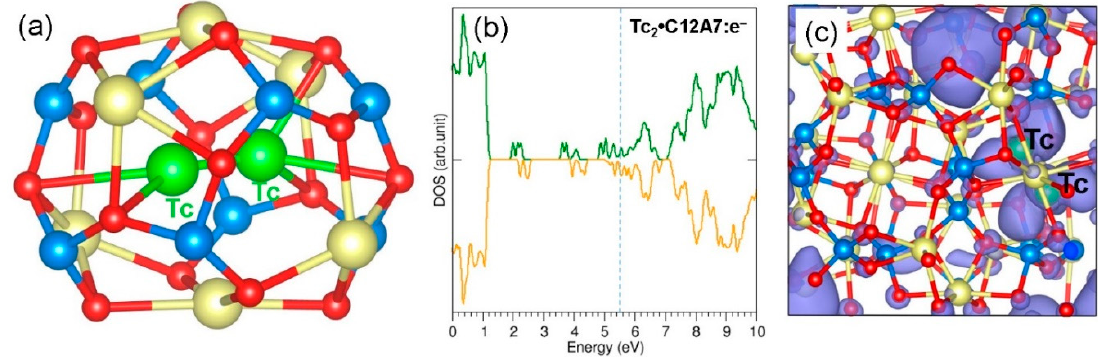
Figure 7. ( a ) Relaxed cage structure showing the Tc dimer in C12A7:e − ; ( b ) DOS plot calculated for Figure 7 . ( a ) Relaxed cage structure showing the Tc dimer in C12A7:e ‒ ; ( b ) DOS plot calculated for Tc 2 :C12A7:e − ; and ( c ) charge density plot associated with the electron Tc 2 :C12A7:e ‒ ; and ( c ) charge density plot associated with the electron distribution .